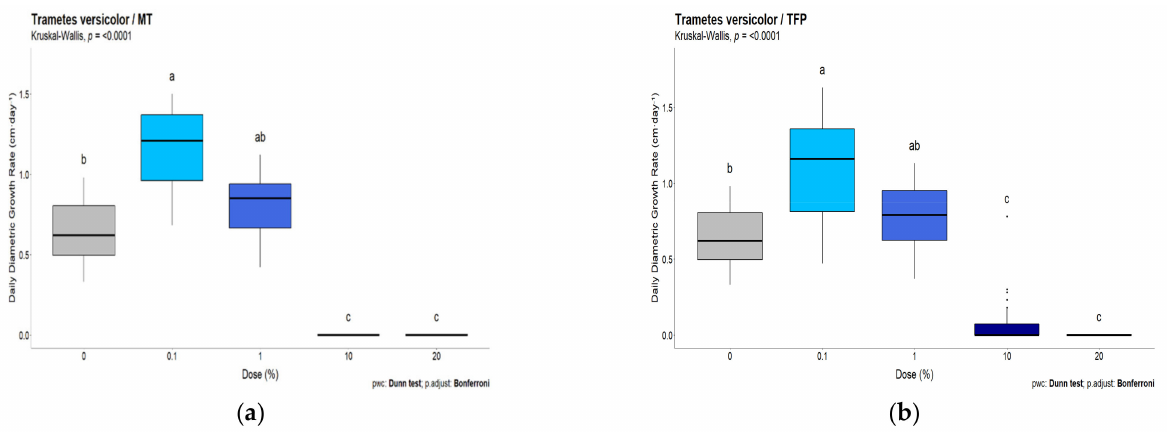
Figure 6. Daily growth rate up to day 7 for T. versicolor at different concentrations of ( a ) mimosa tannin and ( b ) tannin–furanic polymer.